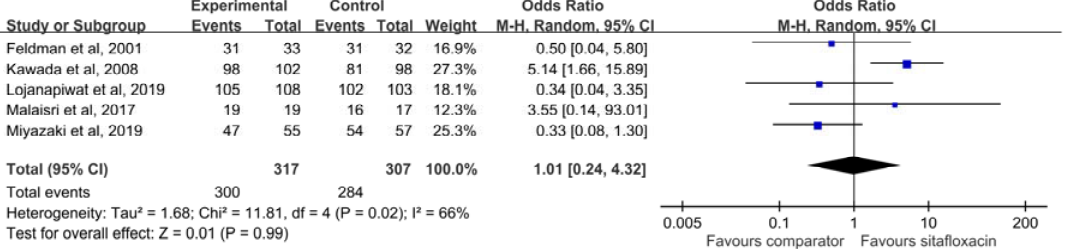
Figure 3. The clinical response rate of sitafloxacin and the comparator in the treatment of acute bacterial infections at the end of treatment visit among the clinical evaluable population.